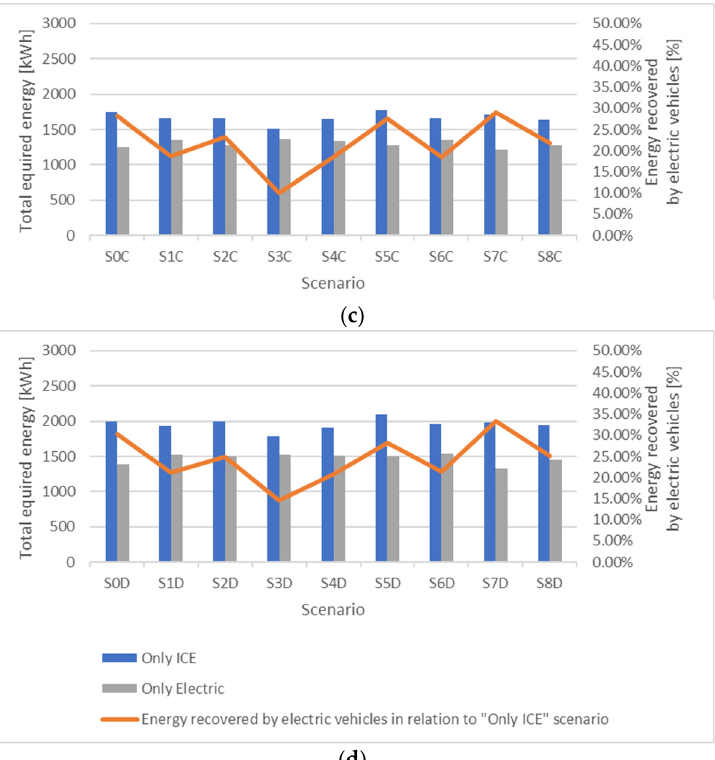
Figure 6. The total energy required for all vehicles to pass through the test area for internal combustion engine (ICE) vehicles and electric vehicles, where ( a – d ) represent SA-SD transportation demand scenarios.